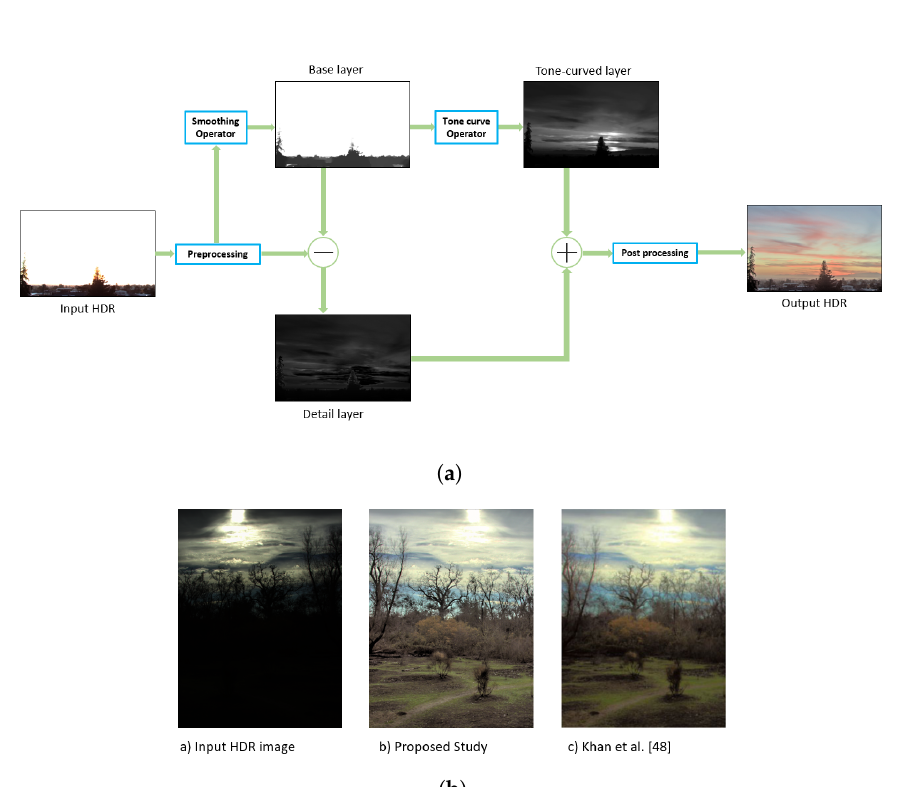
Figure 1. ( a ) Example of the typical approach of tone-mapping procedure. ( b ) Tone mapping performance of the proposed